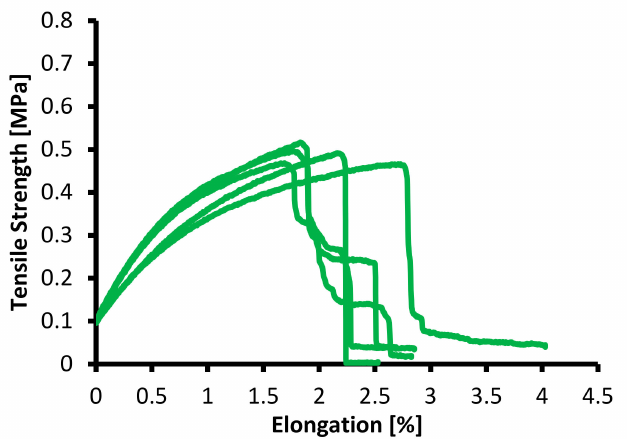
Figure 7. Tensile strength–elongation graph for 15 wt% PVDF with 1% tin dioxide.